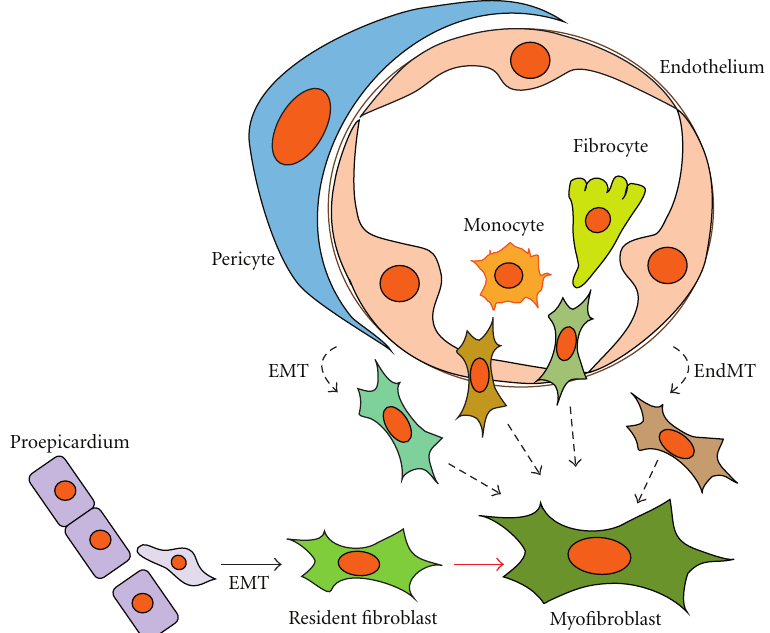
Figure 1: Diverse origins of cardiac fibroblasts. Resident cardiac fibroblasts are thought to arise from the proepicardium and embryonic epicardium during development. In response to fibrogenic stimuli, however, many other cell types, including bone marrow-derived cells, pericytes, and endothelial cells, may also acquire myofibroblast-like phenotypes. This scheme depicts the possible origins of cardiac fibroblasts. EMT: epithelial-to-mesenchymal transition; EndMT: endothelial-to-mesenchymal transition.